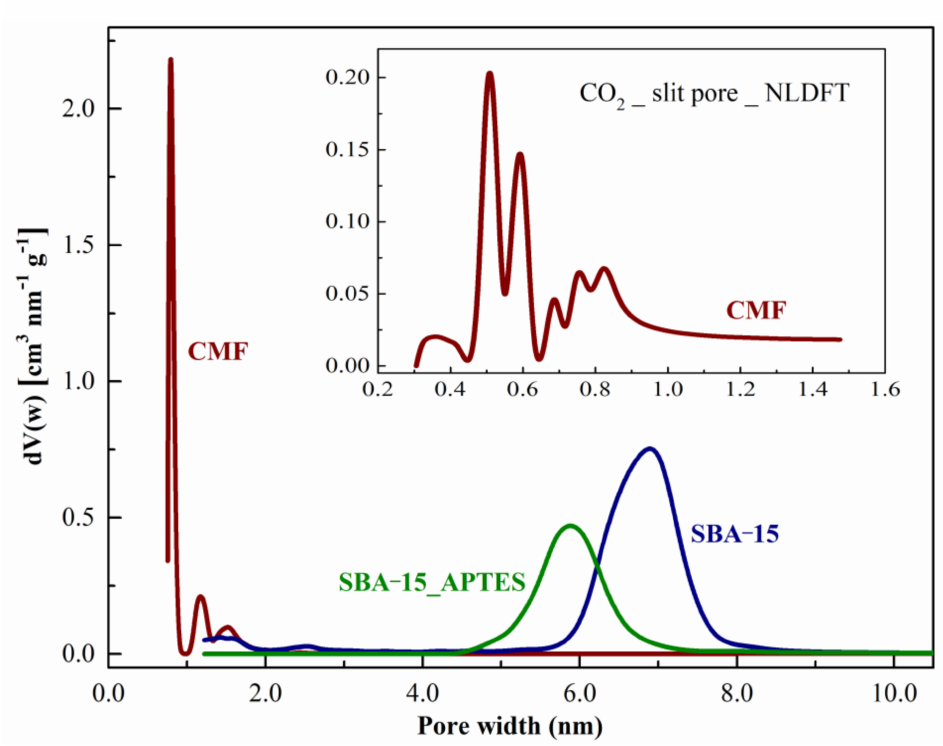
Figure 5. Non-local density functional theory (NLDFT) model pore size distribution of micro- mesoporous